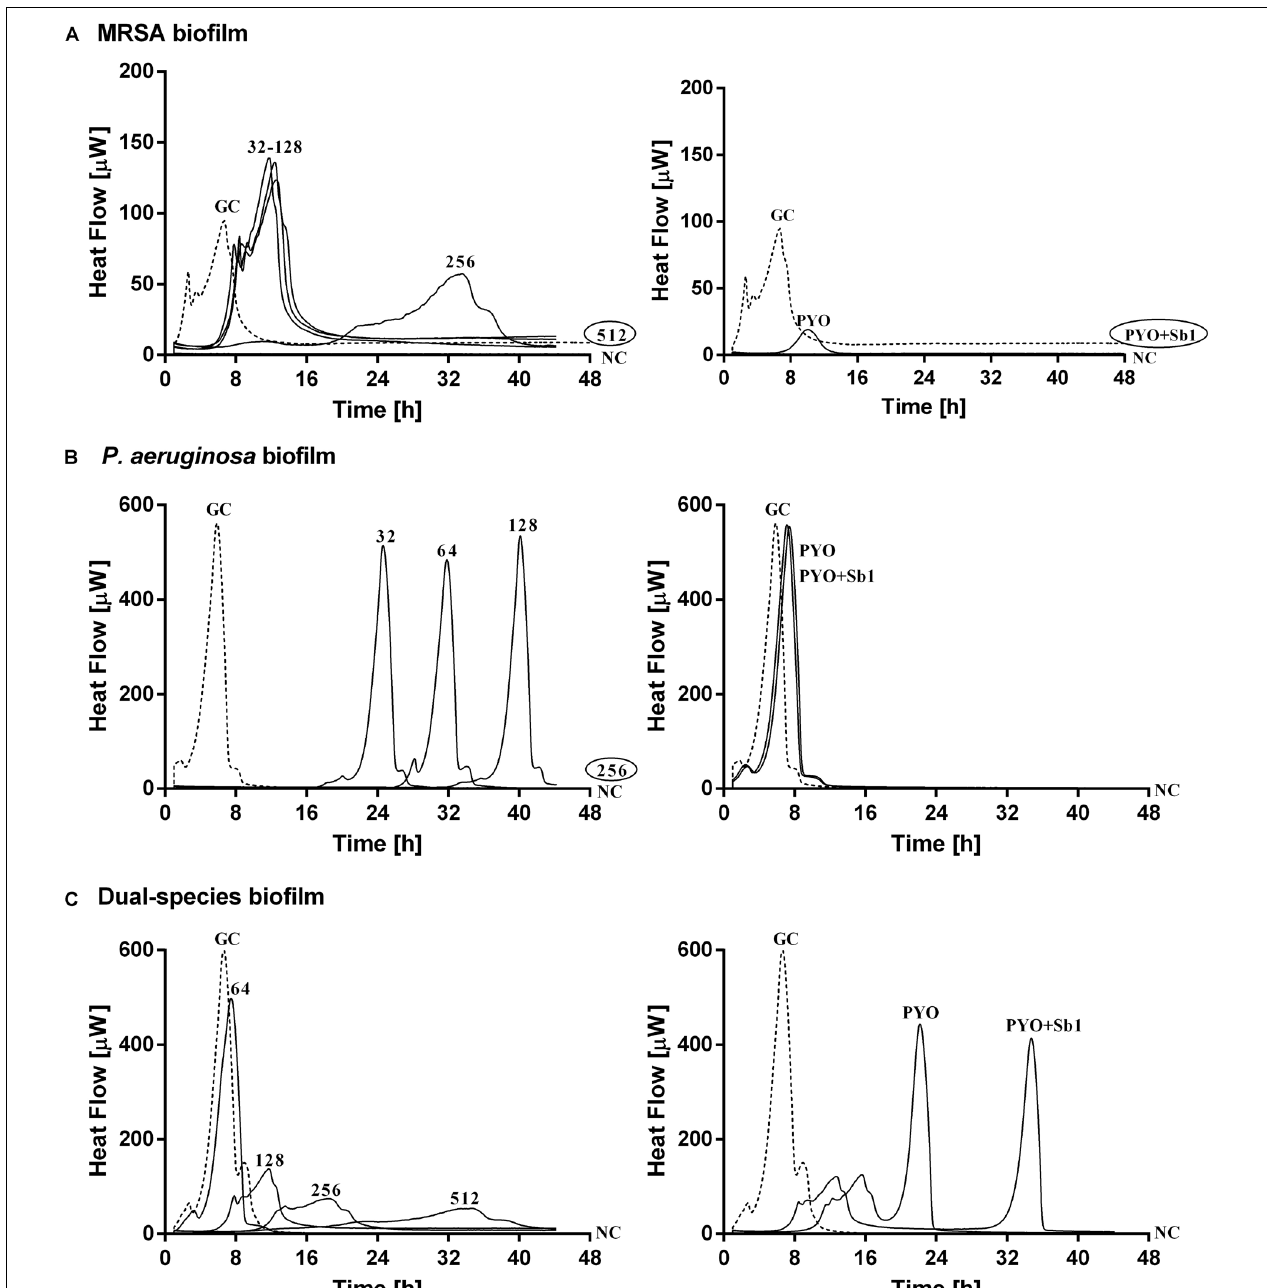
FIGURE 4 | Microcalorimetry analysis of (A,B) mono- and (C) dual-species MRSA (ATCC 43300) and P. aeruginosa (ATCC 27853) biofilms treated with two-fold increasing concentrations of ciprofloxacin (left column, numbers represent concentrations in mg/L of antibiotic) or with phages (right column). Each curve shows the heat produced by viable bacteria present in the biofilm after 24 h of antibiotic or phage treatment. A circled value represents the MBEC, defined as the lowest concentration of antibiotic that strongly reduced the viability of biofilm cells leading to the absence of heat flow production from treated beads when incubated during 48 h in fresh medium and no colonies after sonication and plating. GC, growth control (dashed line); NC, negative control. Data of a representative experiment are reported.